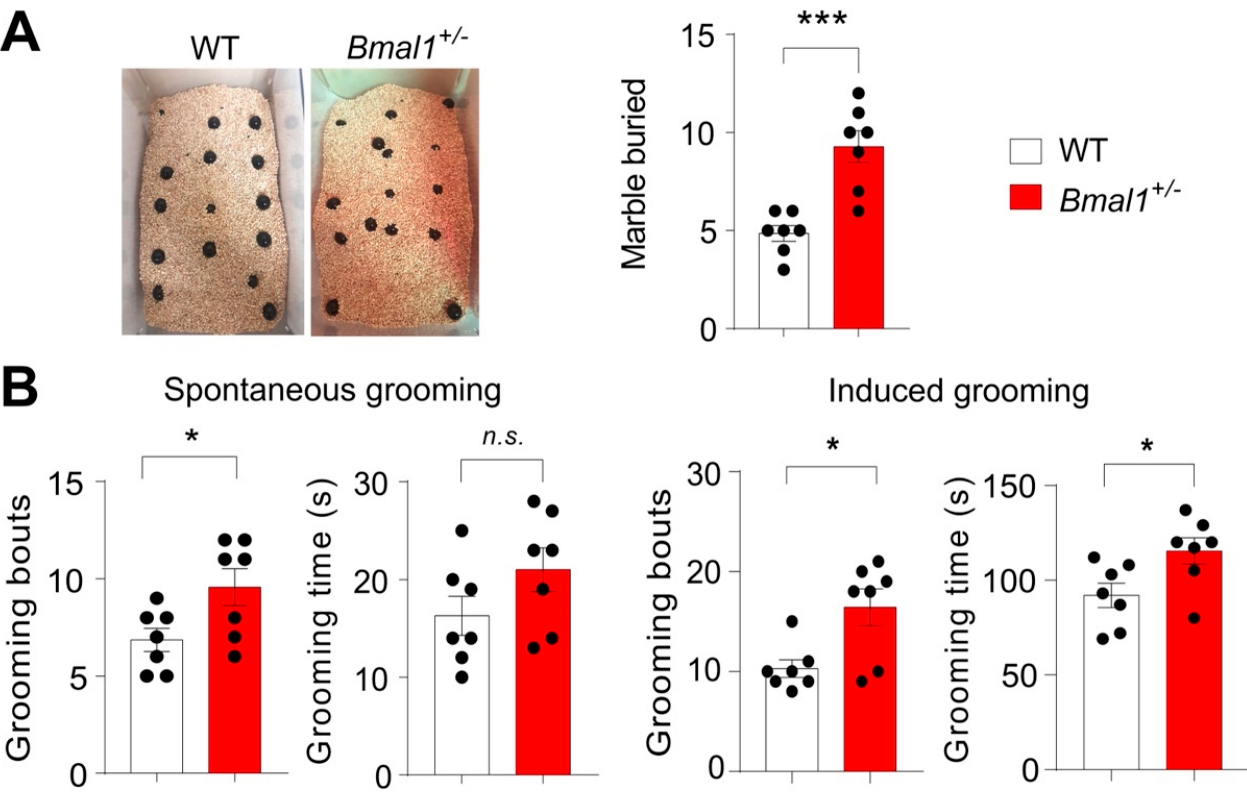
Figure 4. Excessive repetitive behaviors in Bmal1 +/ − mice. ( A ) The marble burying test. Left: Representative images of marble burying by a WT and a Bmal1 +/ − mouse. Right: A bar graph showing the number of marbles buried. Note that the Bmal1 +/ − mice buried more marbles as compared to the WT mice ( t (12) = 4.902, p = 0.0004, Student’s t -test). n = 7 mice/group. ( B ) Mouse grooming behavior analysis. Left: Spontaneous grooming test. Bar graphs indicating grooming bouts (t (12) = 2.426, p = 0.0320, Student’s t -test) and grooming time (t (12) = 1.577, p = 0.1408, Student’s t -test). n = 7 mice/group. Note that the Bmal1 +/ − mice showed increased grooming bouts but a similar total grooming time as compared to the WT mice. Right: Induced grooming test. A gentle water puff was given to mice to induce grooming behavior. Bar graphs indicating grooming bouts (t (12) = 3.025, p = 0.0106,